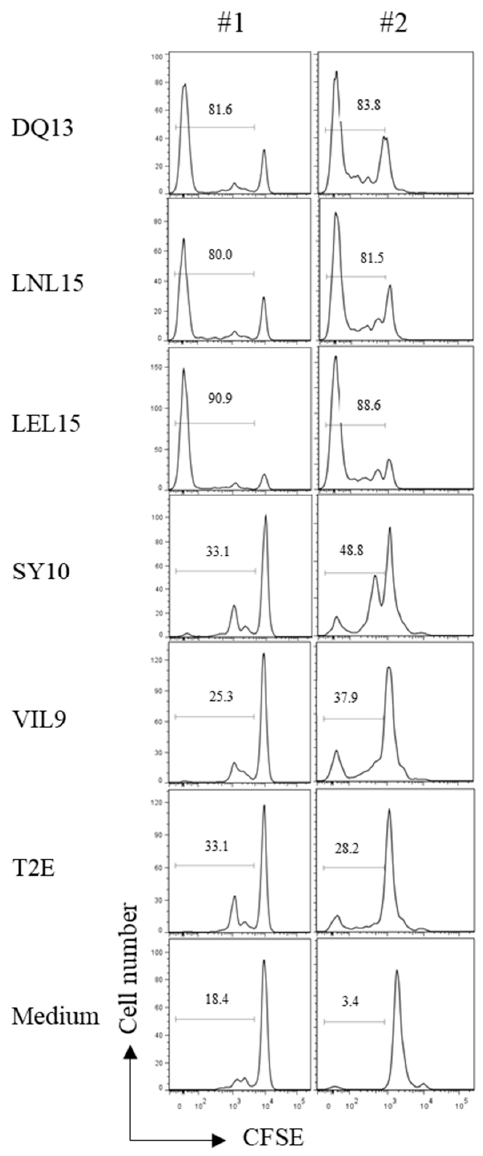
Figure 3. Proliferation profiles of CD8 + T cells after stimulation with peptide pulsed T2E cells. CD8 + T cells were isolated from PBMCs labeled with CFSE and stimulated with peptide pulsed and irradiated T2E cells to analyze which peptides are capable to activate T cells. T2E cells without peptide (T2E) and medium only were used to determine unspecific proliferation. Histograms are gated on CD3 + CD8 + cells. Depicted numbers in each graph indicate for the percentage of proliferated cells. Shown are results from PBMCs from two different individuals (#1, #2).